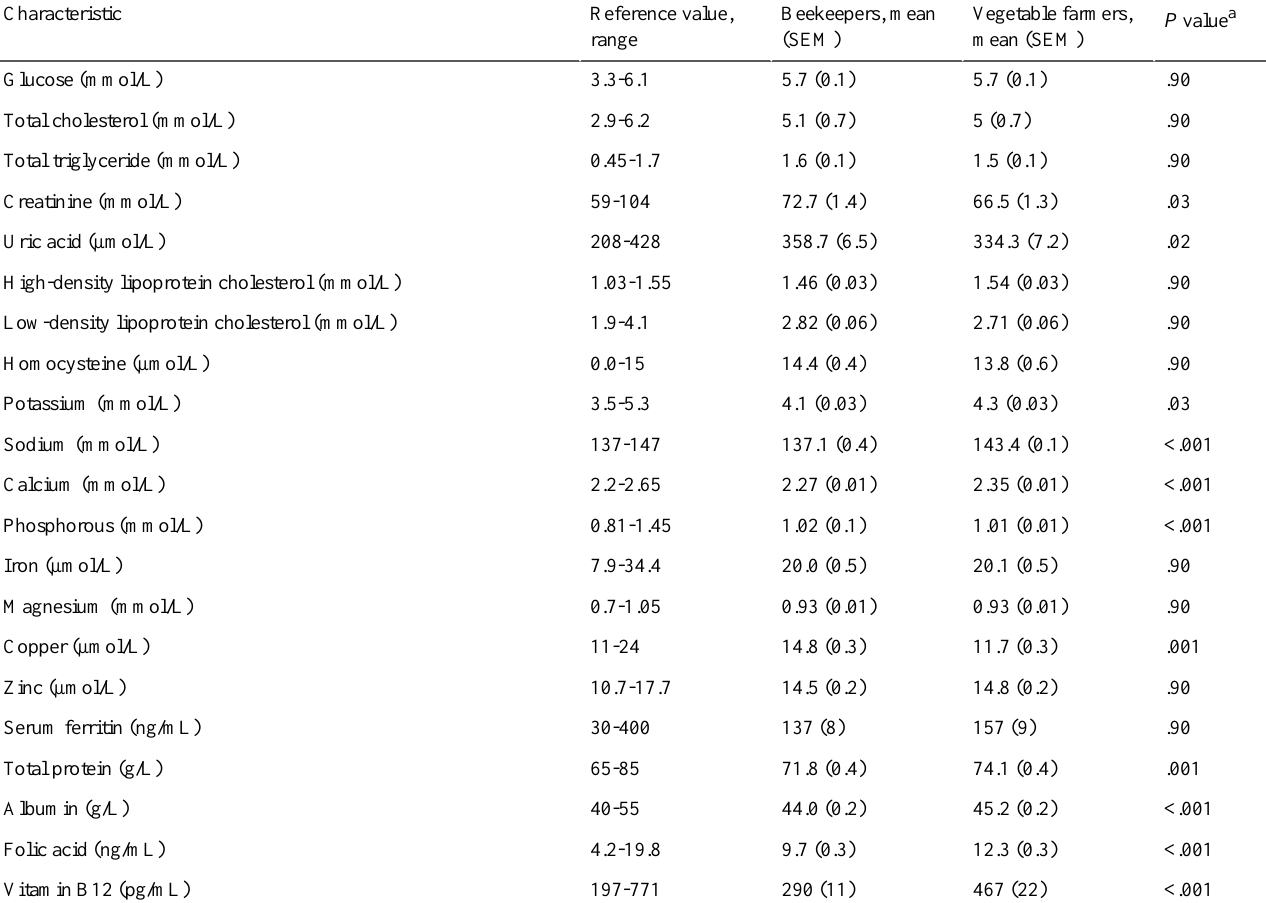
Table 3. Main blood indices of beekeepers and vegetable farmers, sampled from Wuhan, China, between February and April